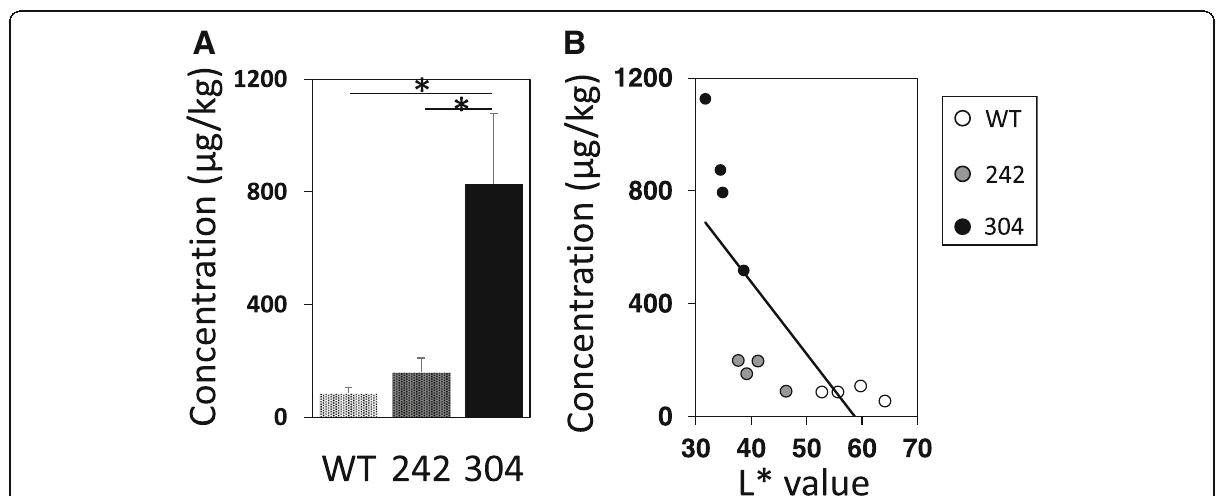
Fig. 2 Correlation between levels of skin pigmentation and molybdenum in the skin. a Molybdenum levels (means±SD) spontaneously accumulated in dorsal skin from wild-type hairless mice (WT, n =4) and HL-RET-mice of lines 242 (242, n =4) and 304 (304, n =4) at 4months of age are presented. Significant differences (** p <0.01) were evaluated by the Tukey-Kramer test. b Correlations between levels of skin pigmentation ( L * values) and levels of molybdenum spontaneously accumulated in dorsal skin of wild-type hairless mice (WT, n =4) and HL-RET-mice of lines 242 (242, n =4) and 304 (304, n =4) at 4months of age are shown. Results analyzed by Spearman ’ s rank correlation coefficient are presented due to no normal